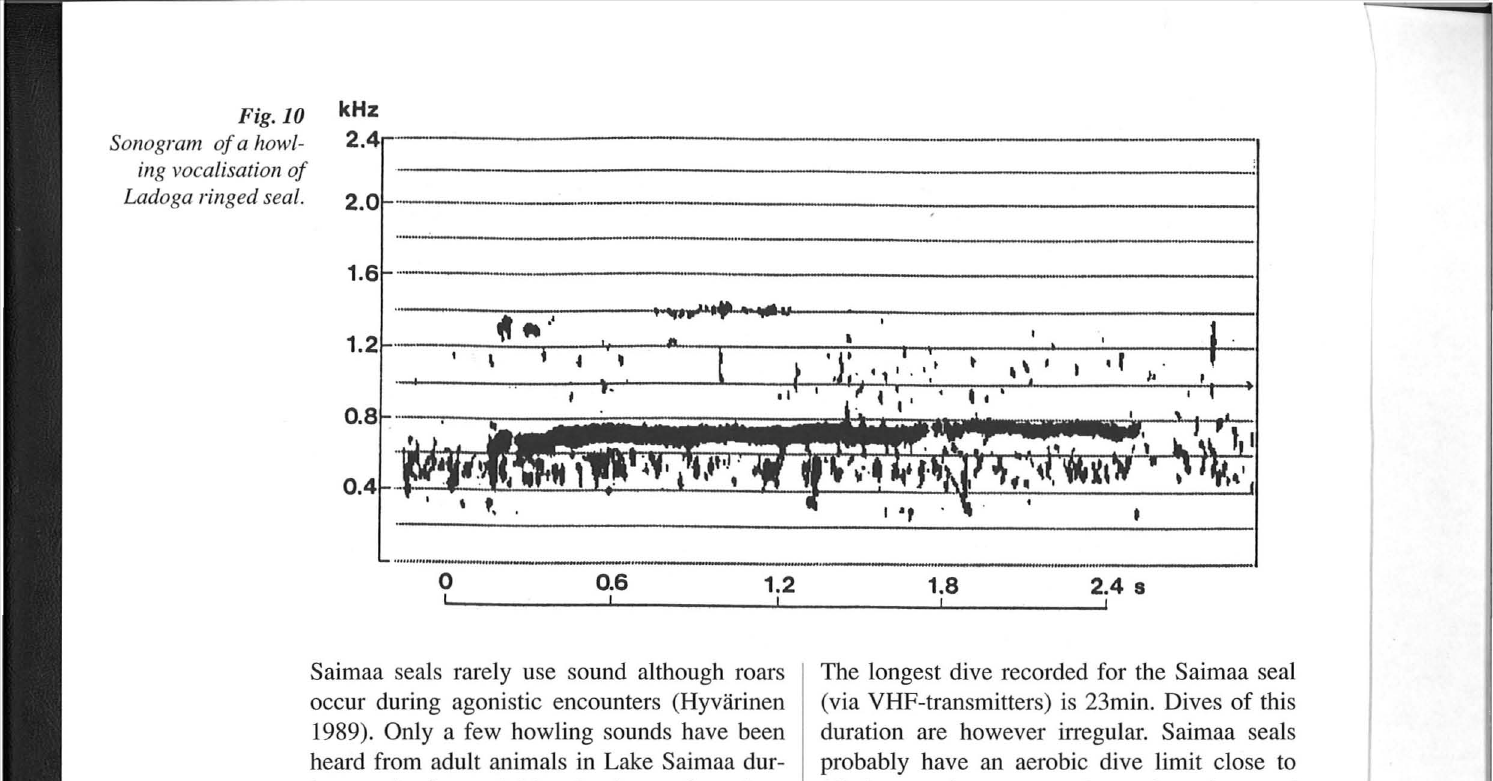
ing vocalisation of Ladoga ringed